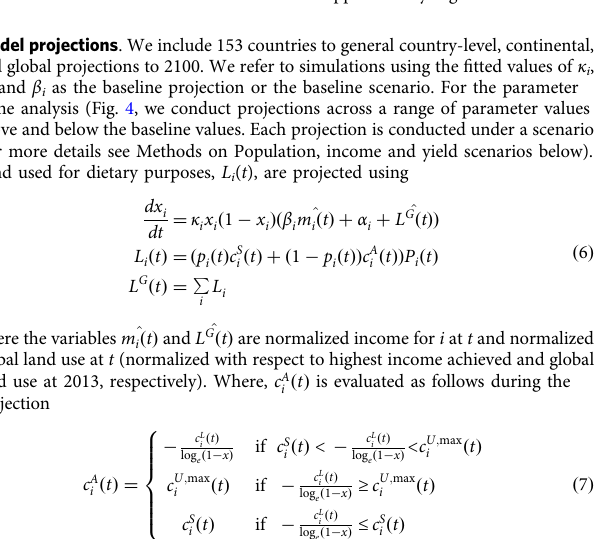
Fig. 12. The time series for c S , c L , and c U ,max are shown for six sample countries. In order to evaluate these values for years beyond 2013 (for purpose